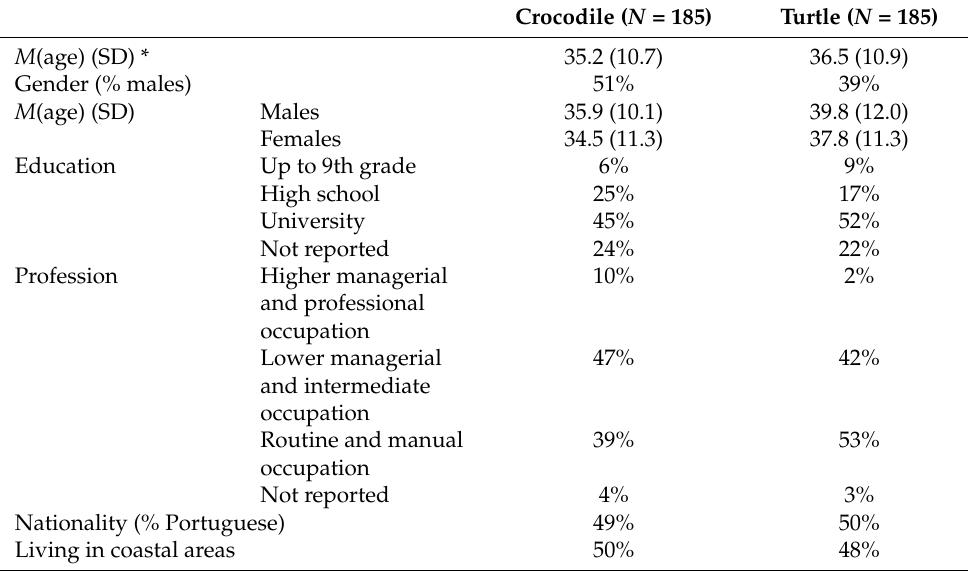
Table 1. Demographic details of participants (for each stimulus